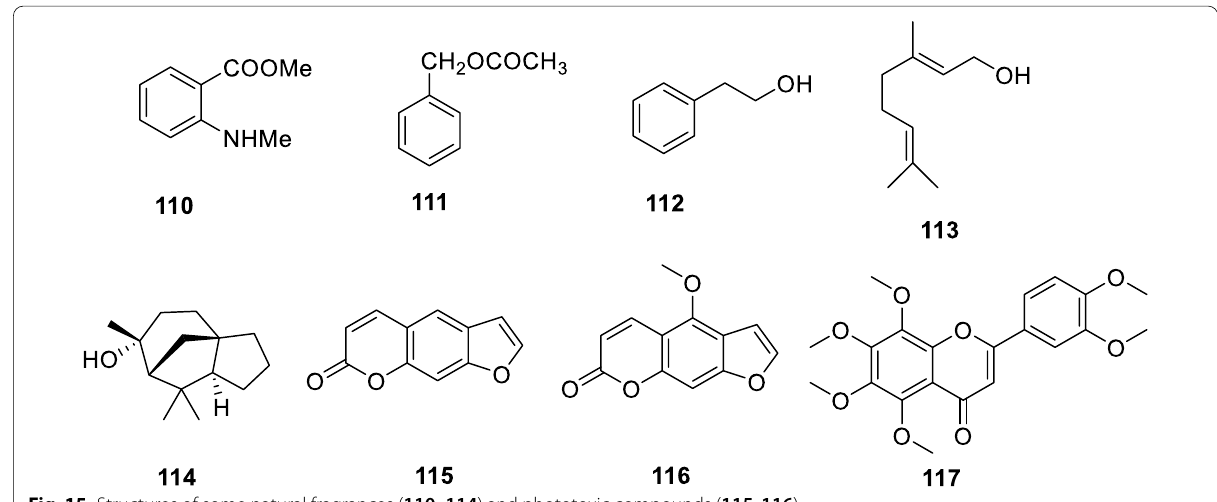
Fig. 15 Structures of some natural fragrances ( 110 – 114 ) and phototoxic compounds ( 115 , 116